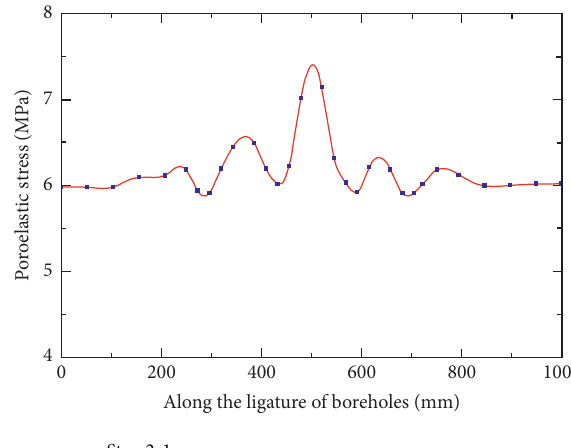
Figure 10: The horizontal poroelastic stress distribution along with the boreholes layout before crack